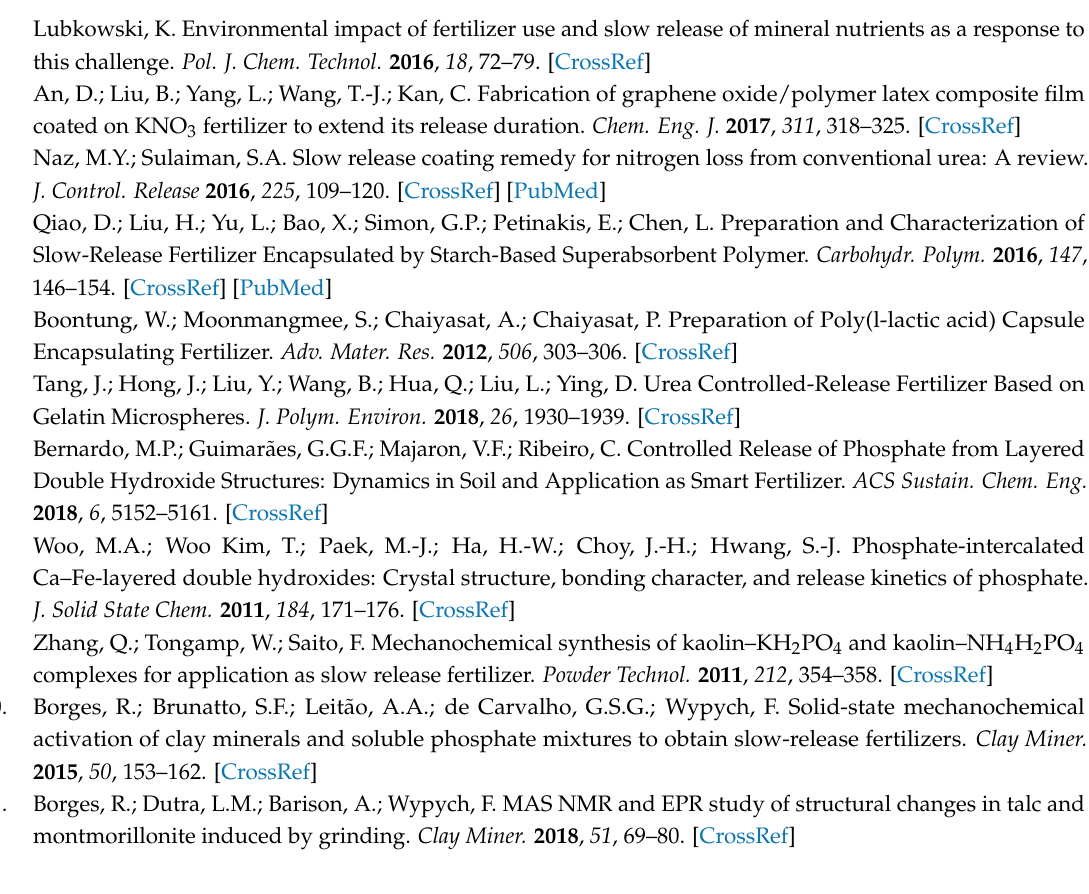
Figure S1: FTIR data of LDH precursors and calcined LDH; Figure S2: FTIR data of milled samples; Figure S3: PXRD of milled samples obtained with CMC; Figure S4: 13 C NMR of milled samples obtained with CMC; Figure S5: 27 Al and 31 P NMR of CMC/MgAl 200 /K 2 HPO 4 ; Figure S6: SEM images of milled samples obtained with CMC; Table S1: XRD data for struvite-K; Table S2: 13 C NMR milled samples obtained with CMC. Author Contributions: R.B. performed the measurements, analyzed the results with the assistance of V.P. and C.F., and participated in editing the manuscript; E.P. performed the solid-state NMR experiments; F.P. corrected the manuscript; V.P. and C.F. supervised the research and finalized the manuscript. Funding: This work was supported by CNPq, CAPES, FINEP and University Clermont Auvergne. RB also thanks CAPES PDSE for the PhD